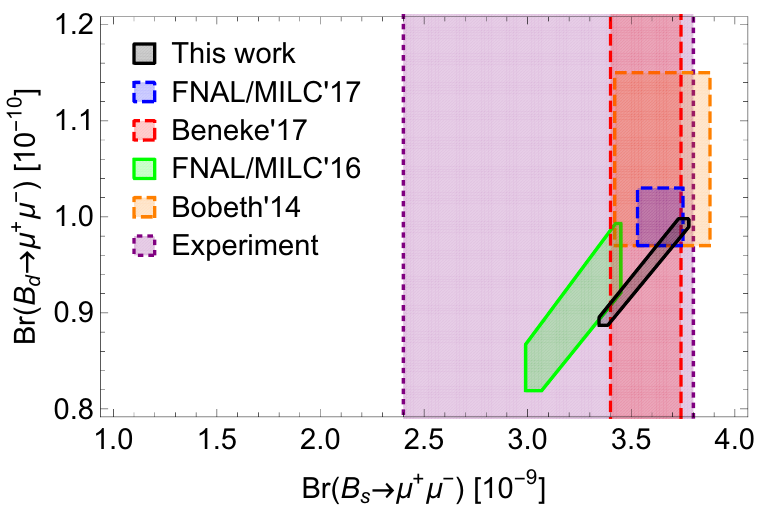
! (cid:22) + (cid:22) (cid:0) ) with q = s; d q ! (cid:22) + (cid:22) (cid:0) ) is s